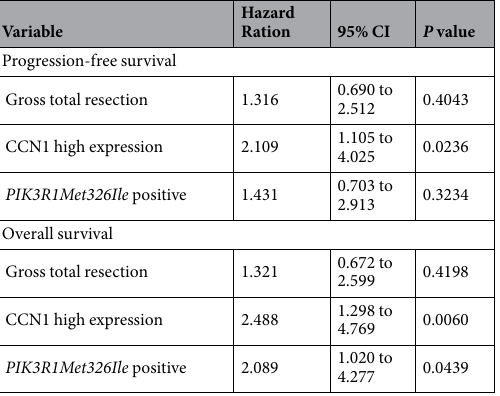
Table 5. Multivariate analysis of prognostic factors for progression-free survival and overall survival in glioblastoma